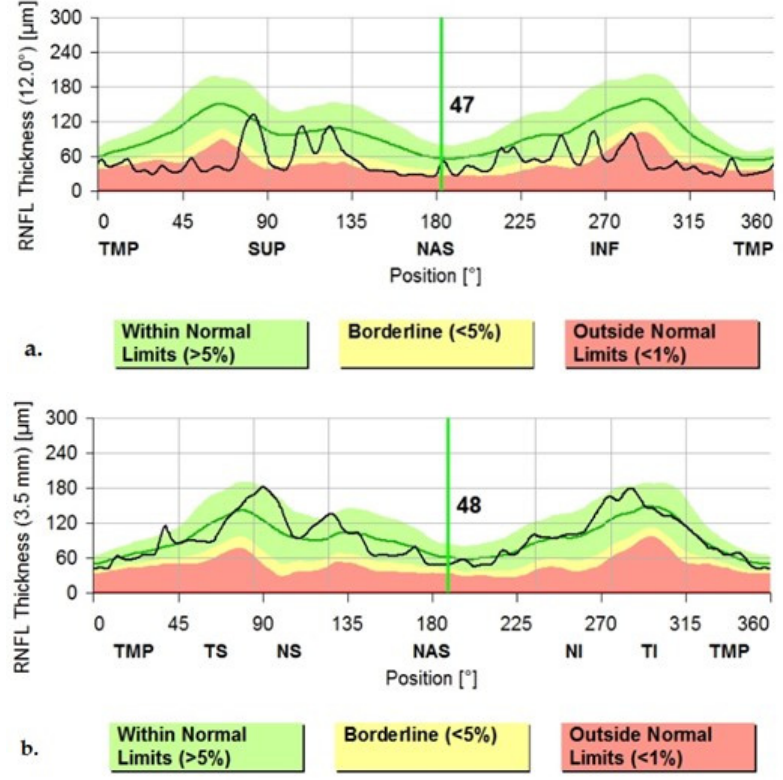
Figure 4. ( a ) The Graphical Analysis of the cpRNFL values in a PD patient (note the black line); ( b ) The Graphical Aspect of the cpRNFL values in a normal subject (Images from our study). TMP—temporal; TS—superior-temporal; NS—nasal-superior; NAS—nasal; NI—inferior-nasal; TI—inferior-temporal.